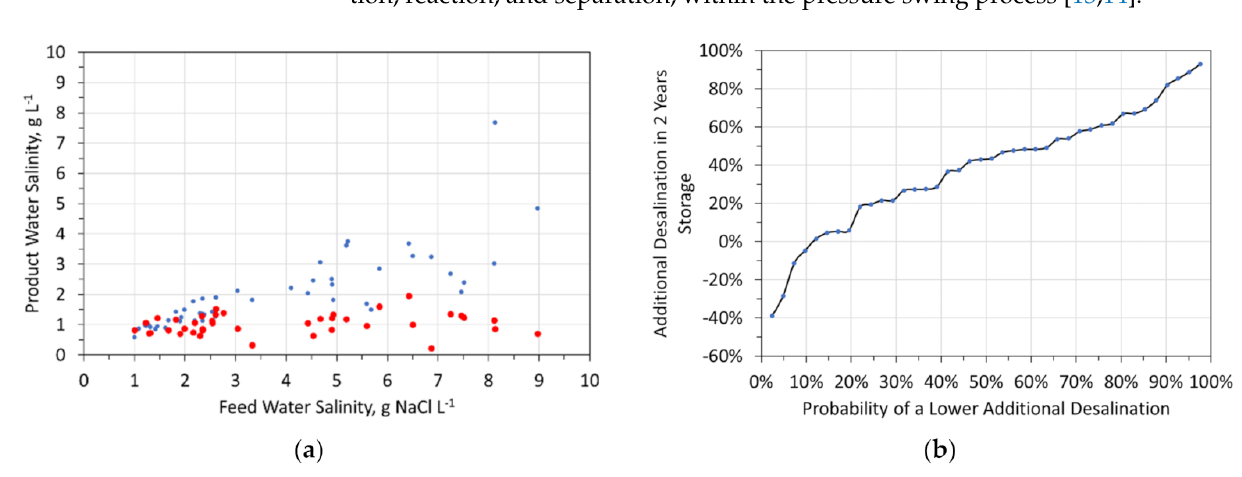
Figure 7. Analysis of stored product water. ( a ) Feed water salinity vs. product water salinity. Blue circles = product water salinity on removal from the reactor; larger red circles = product water salinity following two-year storage; ( b ) additional desalination resulting from 2-year